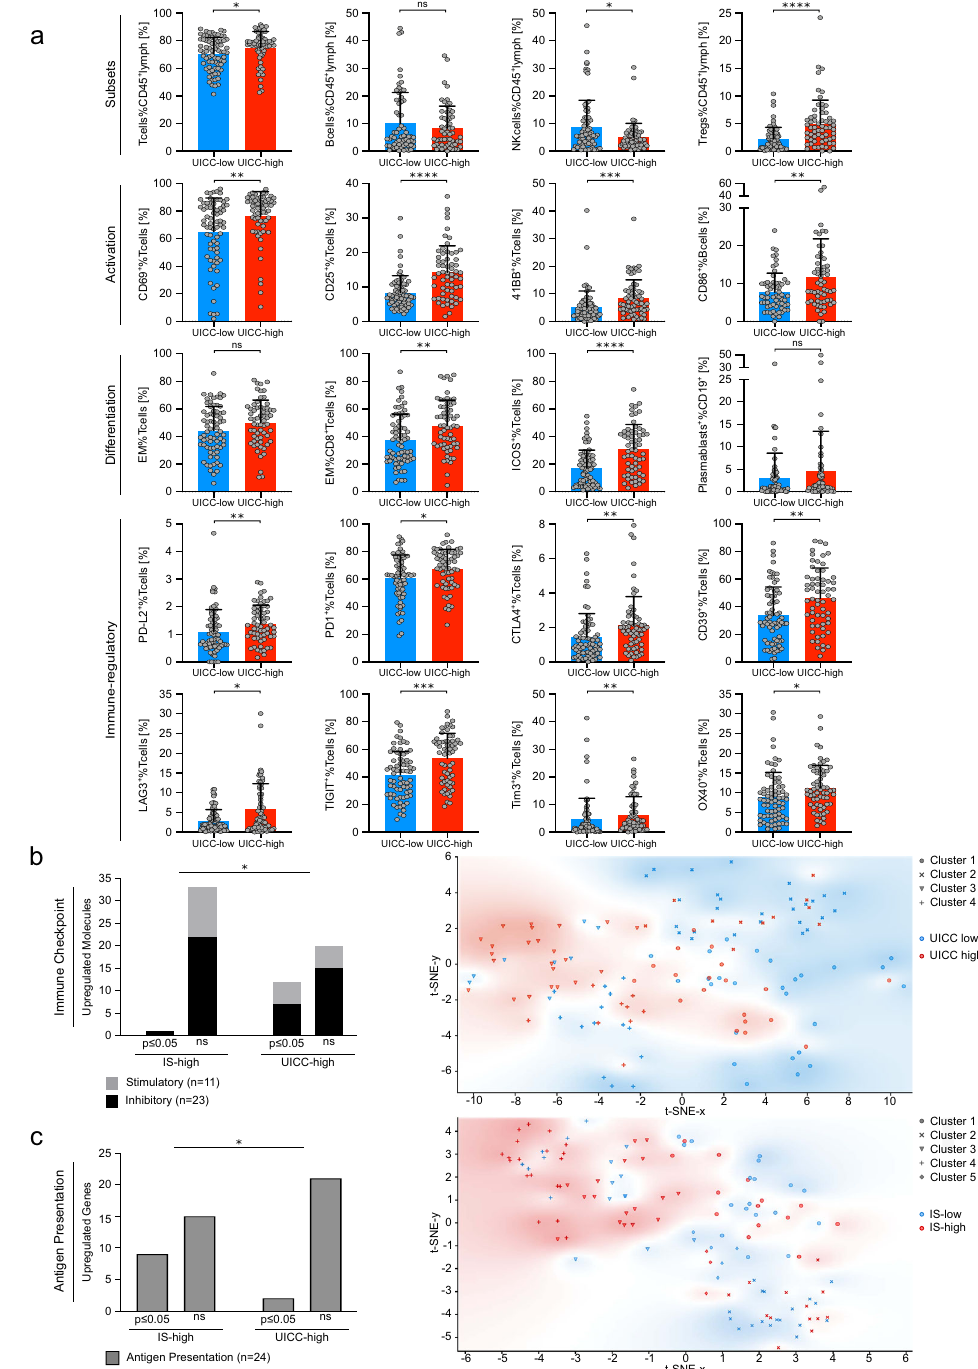
Fig. 6 Advanced tumors show accumulated immune evasion. a Flow cytometry was performed to investigate immune-subset in fi ltration, activation, differentiation and the expression of co-inhibitory molecules on tumor-in fi ltrating T cells. Percentage of the indicated molecules and populations were strati fi ed according to UICC low (UICC I + II) and UICC high (III + IV) patients. b Flow cytometry of tumor-in fi ltrating lymphocytes was performed to investigate immune-checkpoint molecule expression on tumor-in fi ltrating T cells. The gating strategy is described in Supp. Fig. 12. Number of signi fi cantly/ not signi fi cantly upregulated co-stimulatory and co-inhibitory molecules in immune-score low vs. high and UICC low vs. high (marker panel in Fig. 2a). t-SNE plot of patients based on their immune-checkpoint molecule expression on tumor-in fi ltrating T cells (investigated molecules in Fig. 2a). UICC-low patients and UICC-high patients are shown in blue and red, respectively. c Number of signi fi cantly/ not signi fi cantly upregulated genes associated with antigen presentation in immune-score low vs. high and UICC low vs. high (investigated genes in Fig. 4). t-SNE plot of patients based on their expression of genes associated with antigen presentation. Immune-score low and immune-score-high patients are shown in blue and red, respectively. Clusters ( b , c ) are assigned using Louvain community detection. Signi fi cant differences calculated with two-tailed unpaired Mann – Whitney test ( a ) or two-sided Fisher ’ s exact test ( b and c ) are indicated by asterisks. * p ≤ 0.05, ** p ≤ 0.01, *** p ≤ 0.001, **** p ≤ 0.0001. When appropriate, mean ± SD is